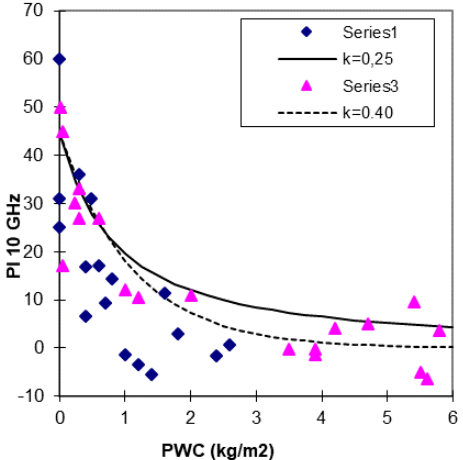
Figure 11. Simulations of PI (at X band) as a function of PWC compared with experimental data of two crop types: narrow-leaf (alfalfa and sugar beet, rhombs) and broad-leaf (corn and sunflower, triangles).